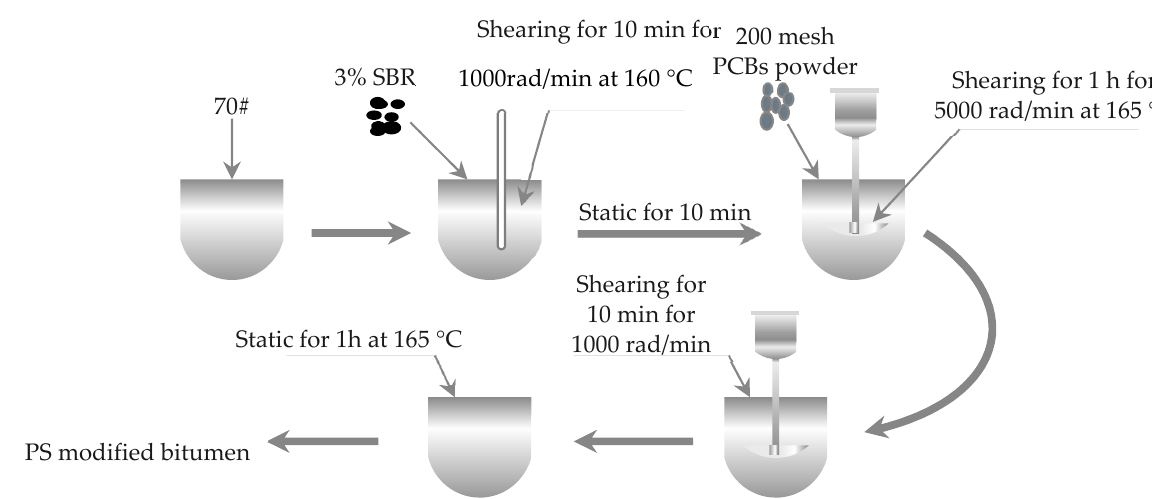
Figure 2. Preparation of PCB non-metallic powder and SBR (PS) modified bitumen.